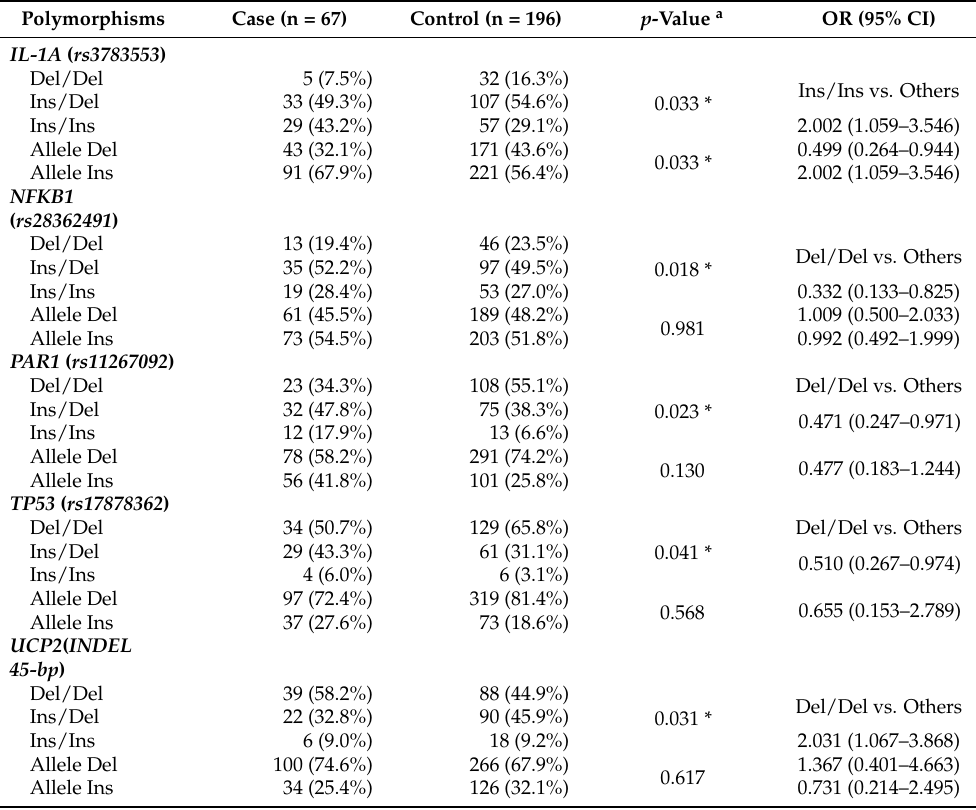
Table 4. Genotypic and allelic distributions of investigated polymorphisms for non-small cell lung cancer patients compared to the control